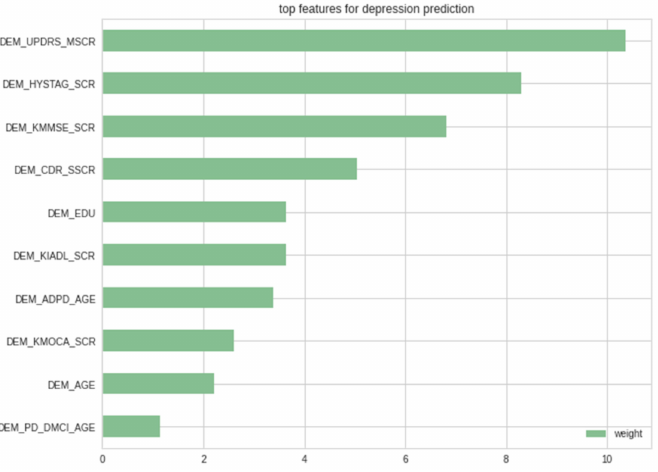
Figure 3. LIME’s top features for depression prediction